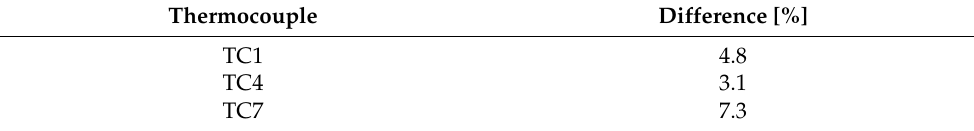
Figure 16. Carbon dioxide readings of three sensors inside the burner. Table 4. Difference between the average temperatures obtained by applying different